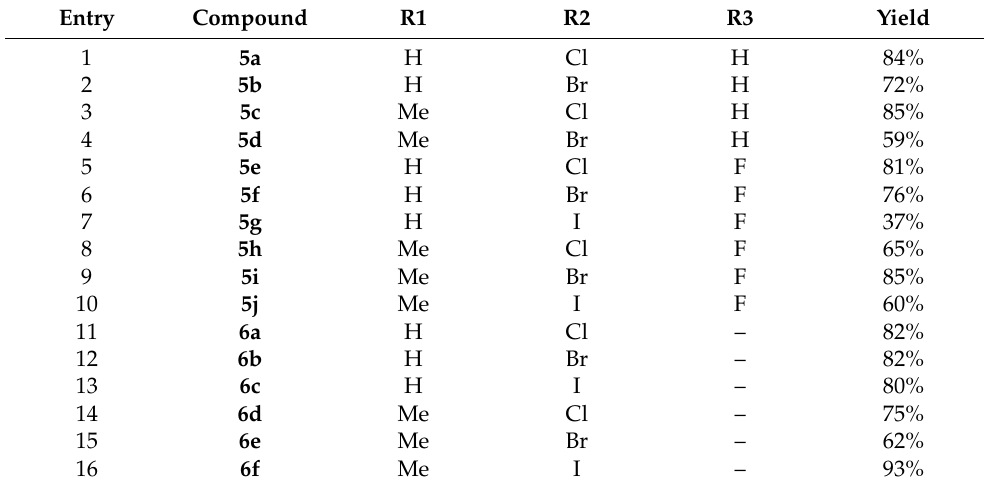
Table 1. Yields of reaction provided for isolated pure products.